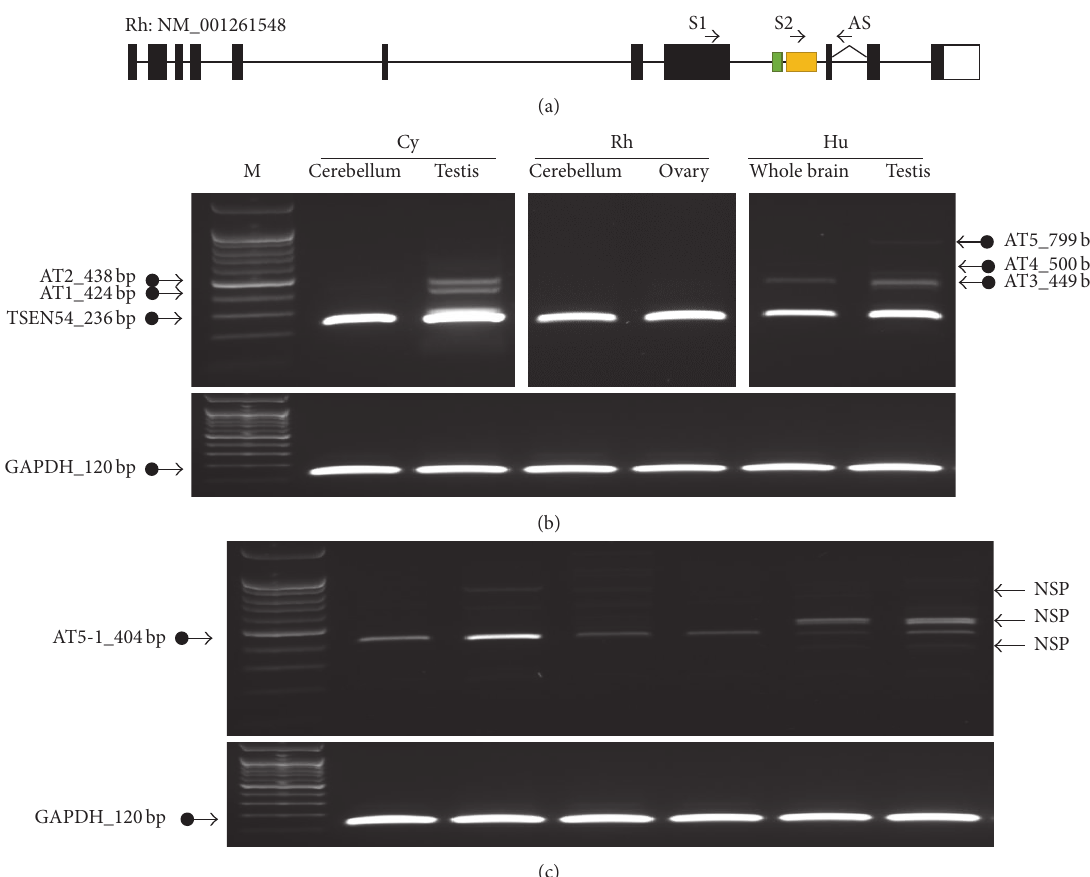
Figure 2: RT-PCR analysis of original and alternative transcripts in cerebellum (or whole brain) and testis (or ovary) tissues of human, rhesus, and cynomolgus monkey. (a) Primer location, RT-PCR amplification using primer 1 pair (b) and primer 2 pair (c). GAPDH (120bp) indicates thepositivecontrol.Mindicatessizemarker.ATindicatesalternativetranscriptandNSPisthenonspecificproducts,confirmedbysequencing.